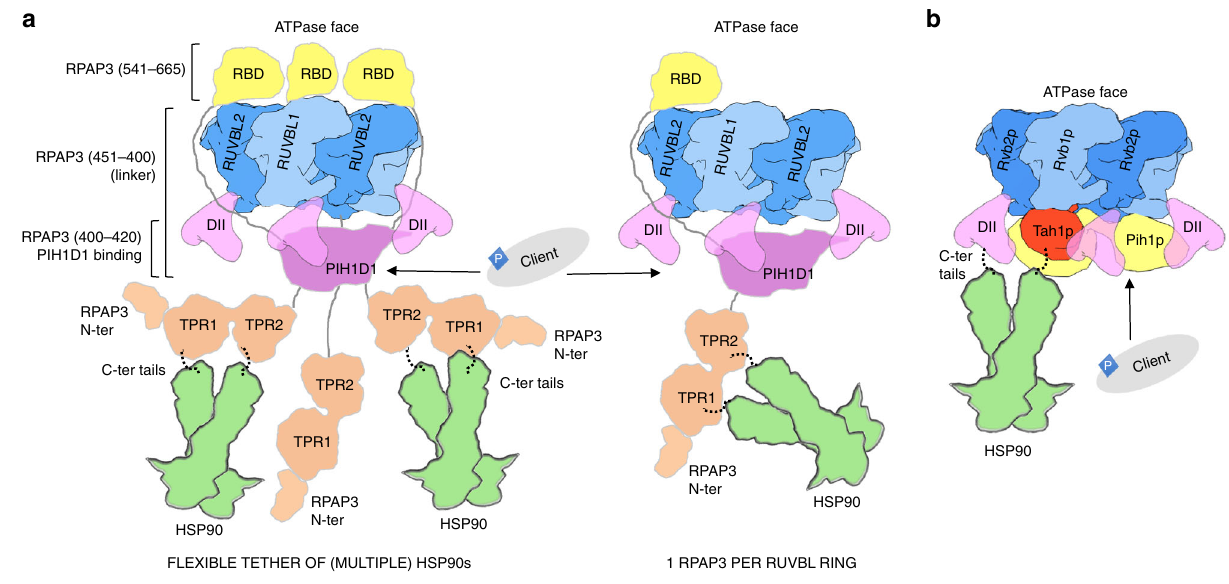
Fig. 8 A cartoon for the structural and functional model for R2TP. a Human R2TP. HSP90 dimers can engage with each R2TP complex with suf fi cient conformational fl exibility to reach and act in a diversity of client proteins. Up to 3 RBDs serve to anchor 3 RPAP3 to the RUVBL1 – RUVBL2 scaffold, whereas a central segment of RPAP3 helps to recruit PIH1D1. The number of RPAP3 molecules per RUVBL ring in vivo is not known, and two options are shown in the fi gure. A long and poorly structured link between the RBD and TPR domains in RPAP3 results in substantially conformational fl exibility of the TPR regions. For simplicity, although 3 RBDs are bound to the RUVBL ring, only 2 RPAP3s are shown bound to HSP90 in the cartoon. b Yeast R2TP. Conformational adaptability of yeast R2TP is limited to the fl exibility of the C-terminal tails in Hsp90. Only one Hsp90 binds each